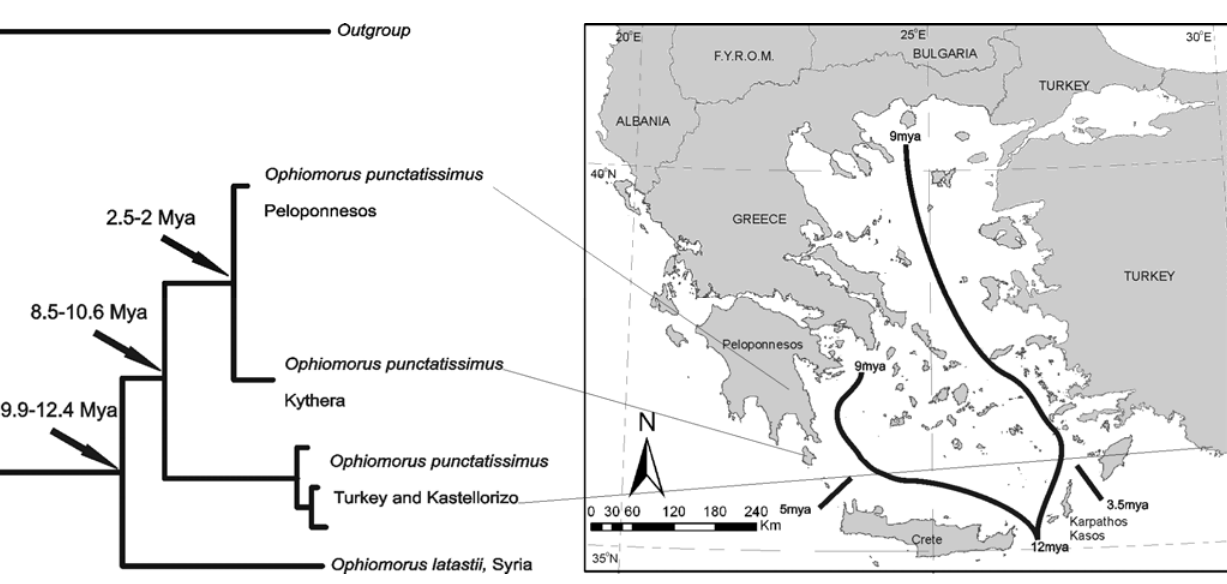
Figure 9. Phylogenetic relationships and distribution of Ophiomorus taxa in the area. The most plausible scenario is that the species existed in the area that was separated into two with the 12-9 MYA splitting of the Aegean. If this hypothesis is correct, fossils of the species are expected to be found in Cyclades—possibly even